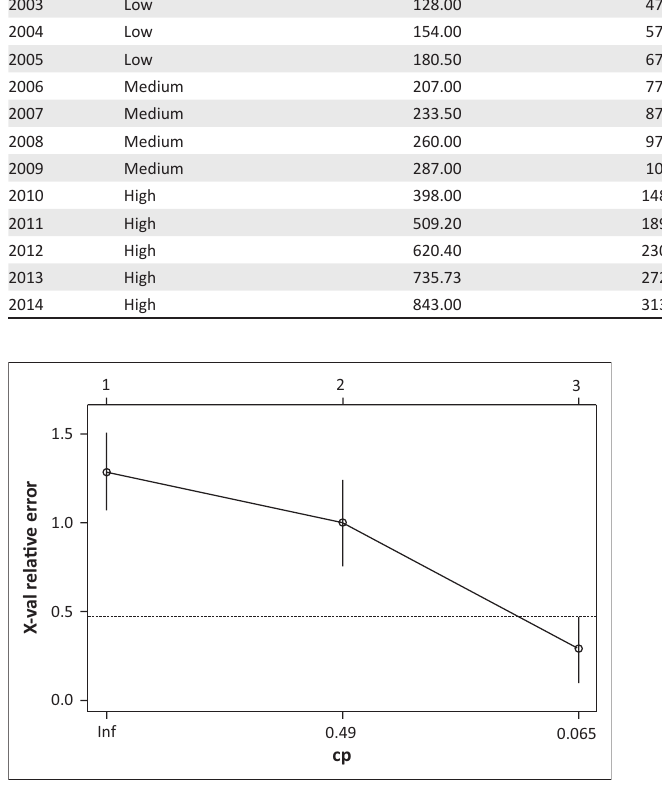
FIGURE 5: Classification of the level of vulnerability with the Classification and Regression Tree